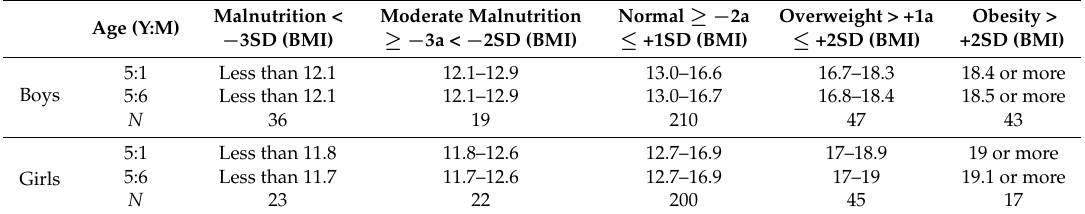
Table 1. Classification ranges 1 and number of boys and girls in each group.